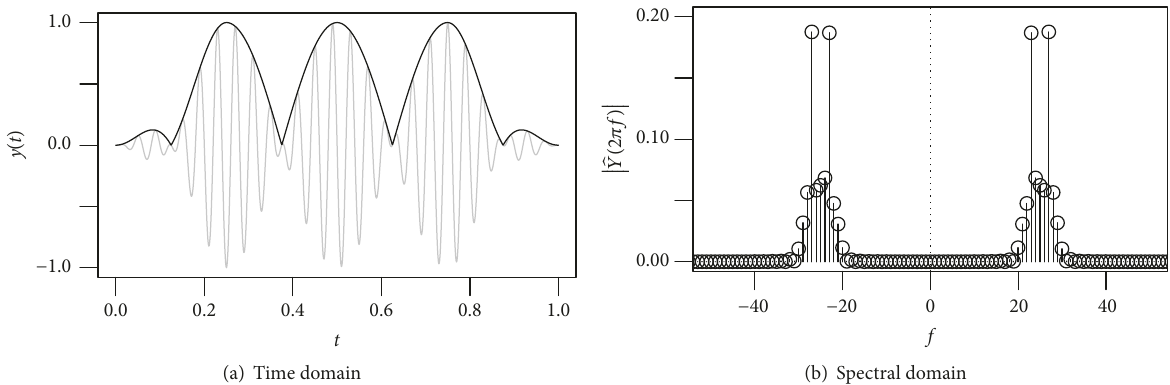
Figure 8: The envelope function of a signal. The spectrum (b) clearly indicates the bandwidth, which is needed to reconstruct the envelope. In case of a noisy signal the band pass filter must have at least this width to resolve reasonable results.